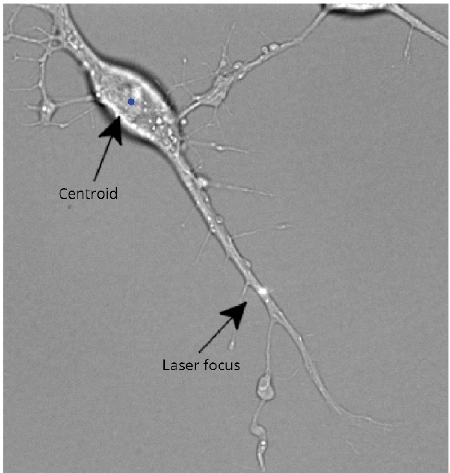
Figure 3. Laser-induced transection injury of an axon. Image showing a laser beam focused on neurite extension from a differentiated RGC-5 cell. Laser pulse was set to 7.5 nJ at 76 MHz, with exposure